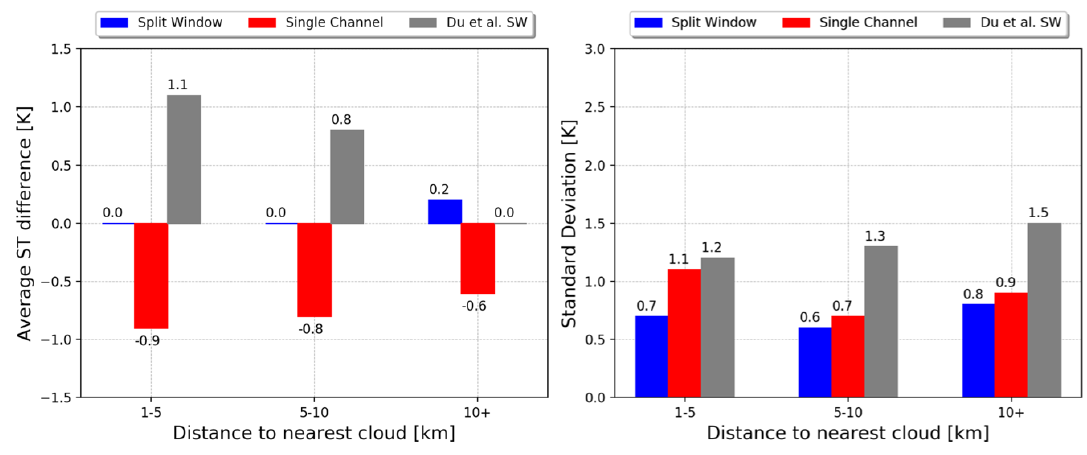
Figure 10. Results over water sites: the average differences between the reference temperature measurements and the Landsat-derived surface temperatures for the three retrieval methodologies ( left ), and the corresponding standard deviations of the residuals ( right ). Note that there is no reference data for clouds within 0–1 km of a water